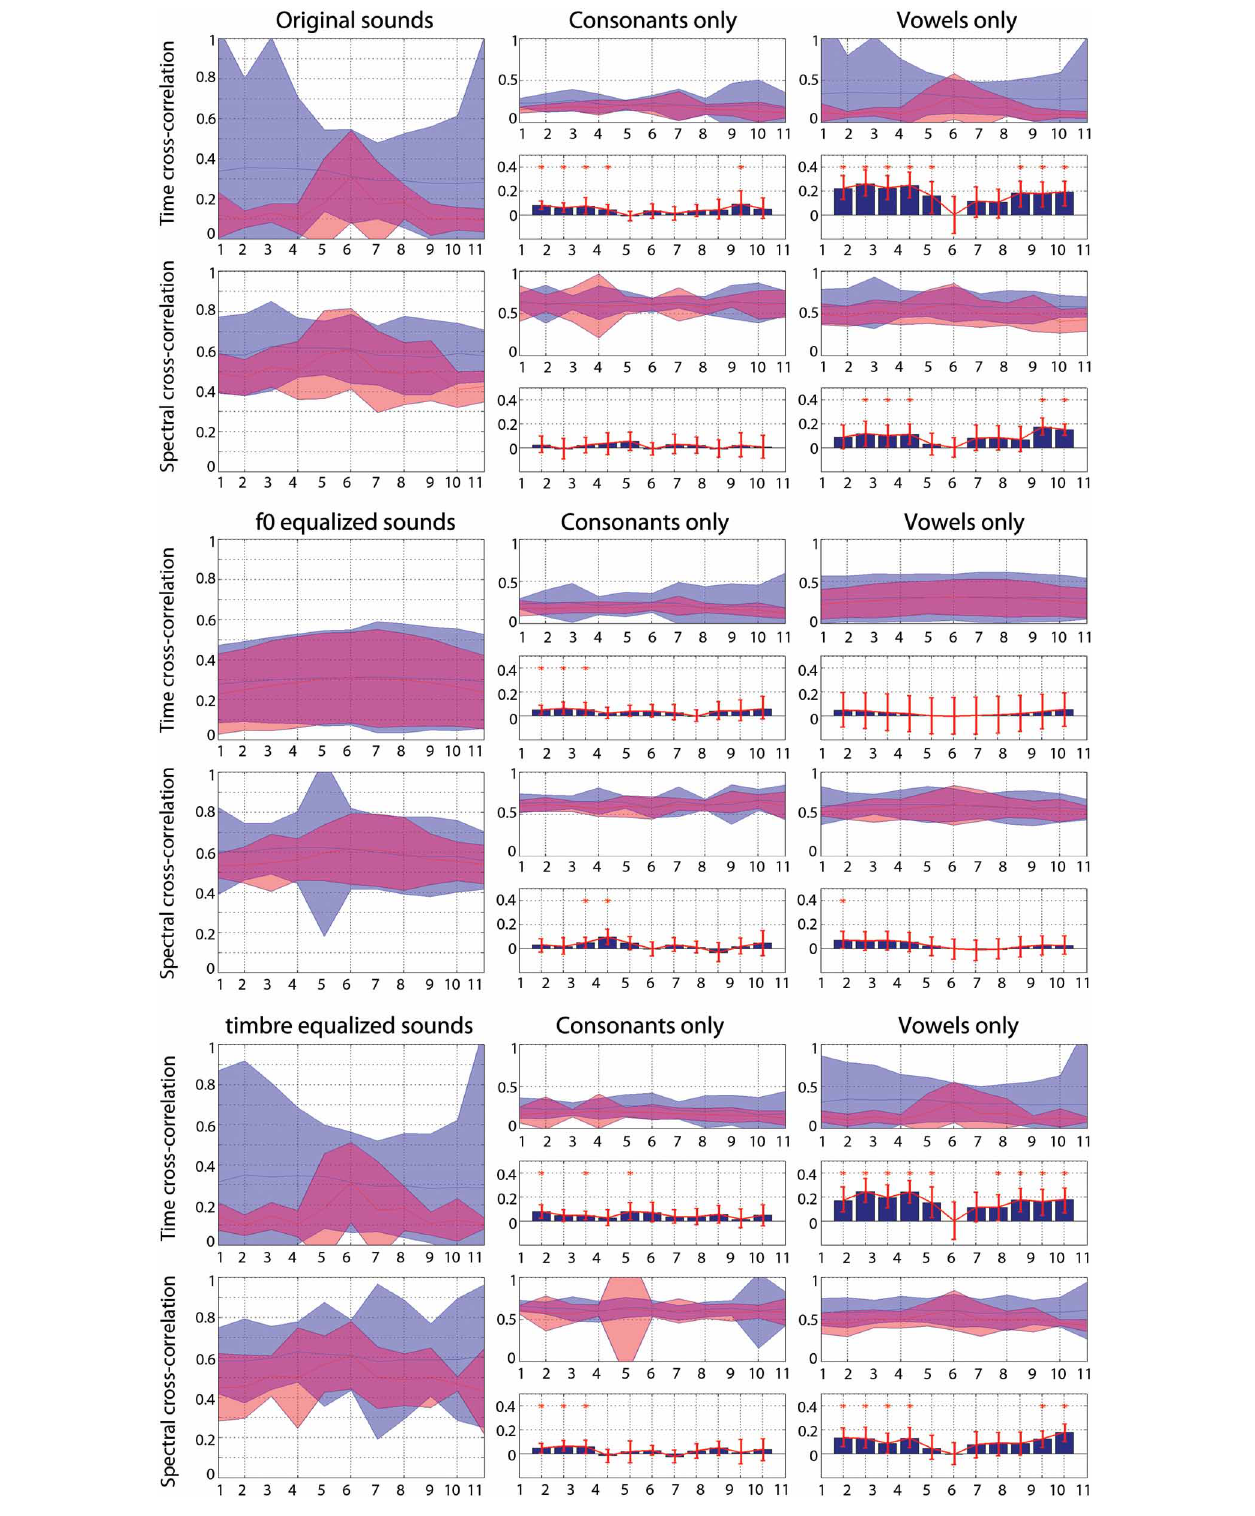
FIGURE A2 | Cross-correlations between sounds grouped by gender (blue) or phoneme (red). Each plain curves represent the 95% confidence intervals of cross-correlation values. High values indicate high similarities. For the consonant and the